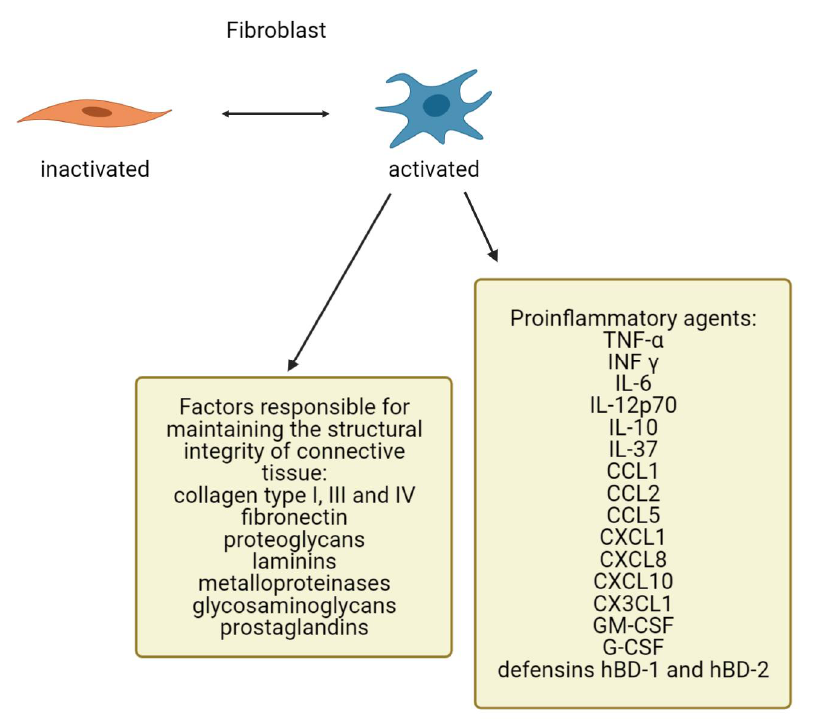
Figure 1. Expression of ECM components and proinflammatory factors by fibroblasts (created by